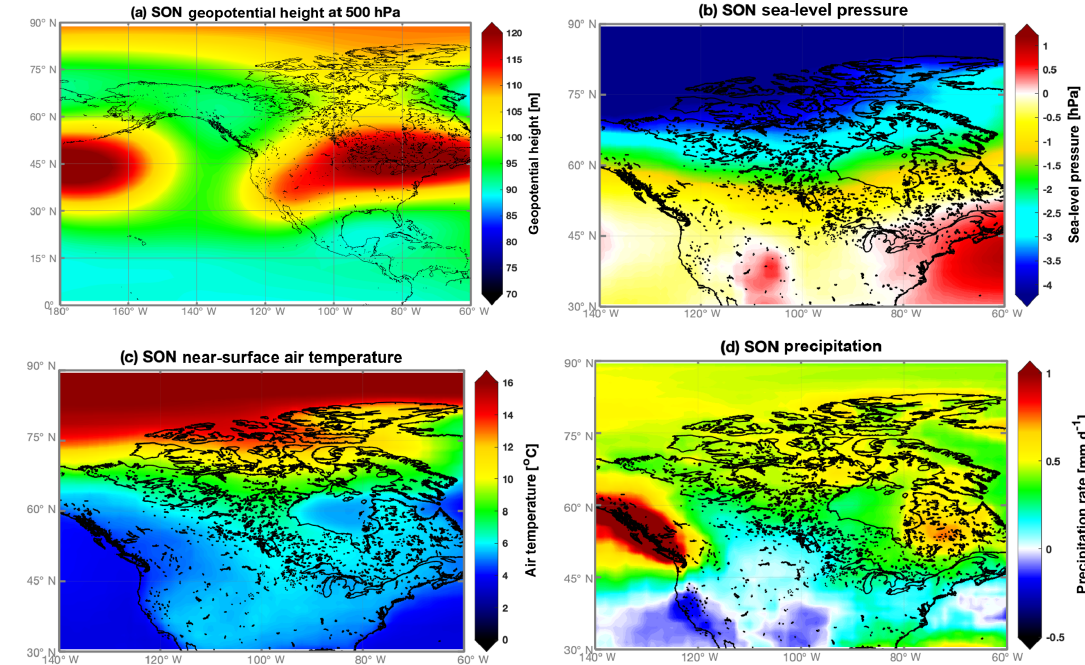
Figure 2. CMIP5 RCP8.5 projected changes in the 39-model ensemble mean between the periods (2081–2099) and (1981–2000) for autumn (SON). For each 3-month period, the four panels show differences in (a) 500hPa height (m), (b) sea-level pressure (hPa), (c) near-surface (2m) air temperature ( ◦ C), and (d) precipitation rate (mmd − 1